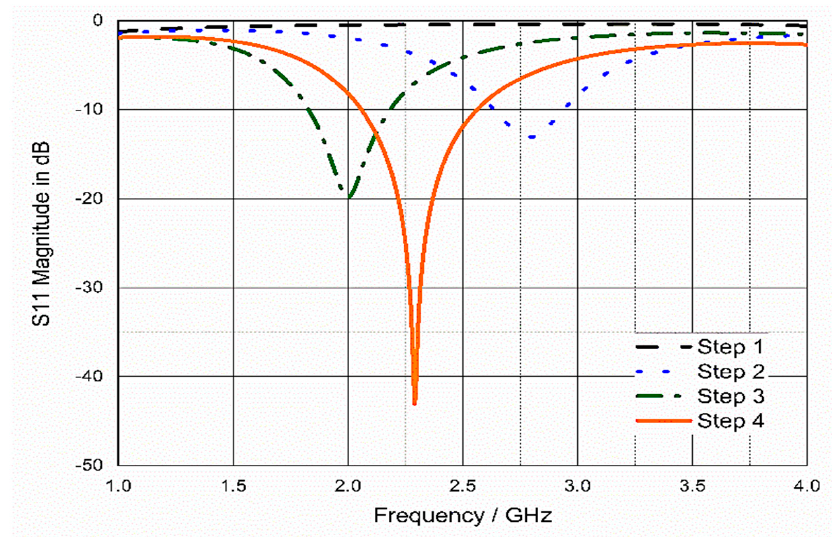
Figure 4. S 11 of the four design steps of WUCIA.